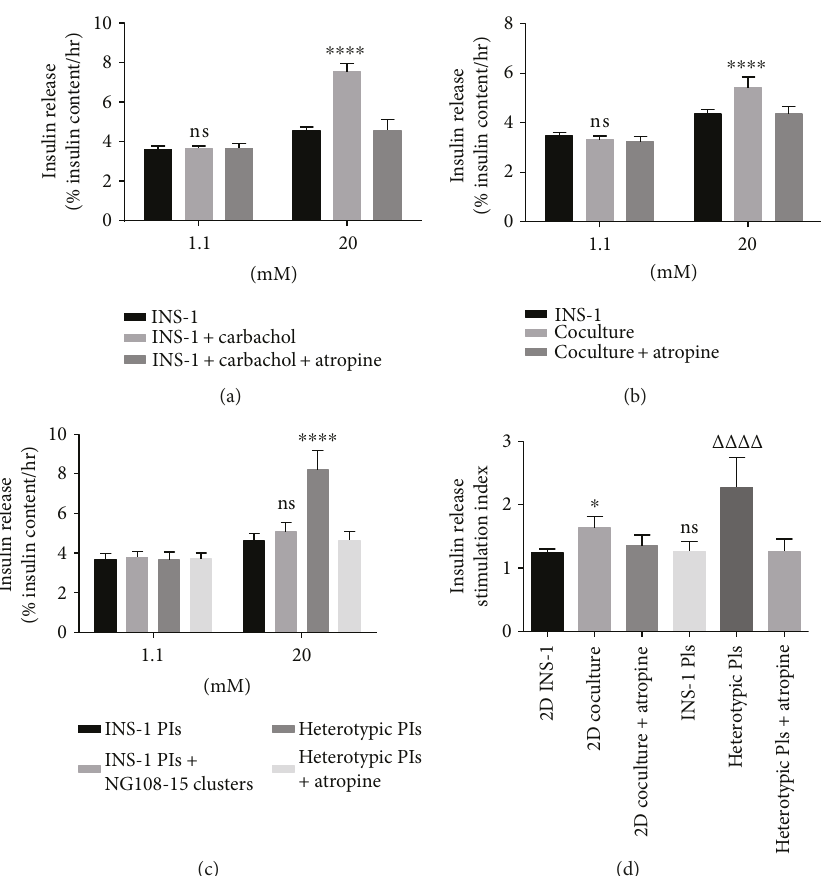
Figure 5: Glucose-stimulated insulin secretion assay. (a) Secretory responses of INS-1 cells with or without carbachol (10 μ M) or atropine sulfate (10 μ M). ∗∗∗∗ p < 0 0001 and ns compared to INS-1 group, n = 4 . (b) Secretory responses of INS-1 cells and 2D coculture cells. ∗∗∗∗ p < 0 0001 and ns compared to INS-1 group, n = 8 . (c) Secretory responses of INS-1 PIs and INS-1 PIs+ NG108-15 clusters mixture and heterotypic PIs. ∗∗∗∗ p < 0 0001 and ns compared to INS-1 PI group under 20 mM glucose stimulation, n = 8 . (d) Stimulation index of all groups. ∗ p < 0 05 compared to 2D INS-1 group. ΔΔΔΔ p < 0 0001 compared to INS-1 PI groups. ns compared to 2D INS-1 group. (a, b, and c) The data are expressed as percentages of total insulin content. Results are means ± SD of at least four independent